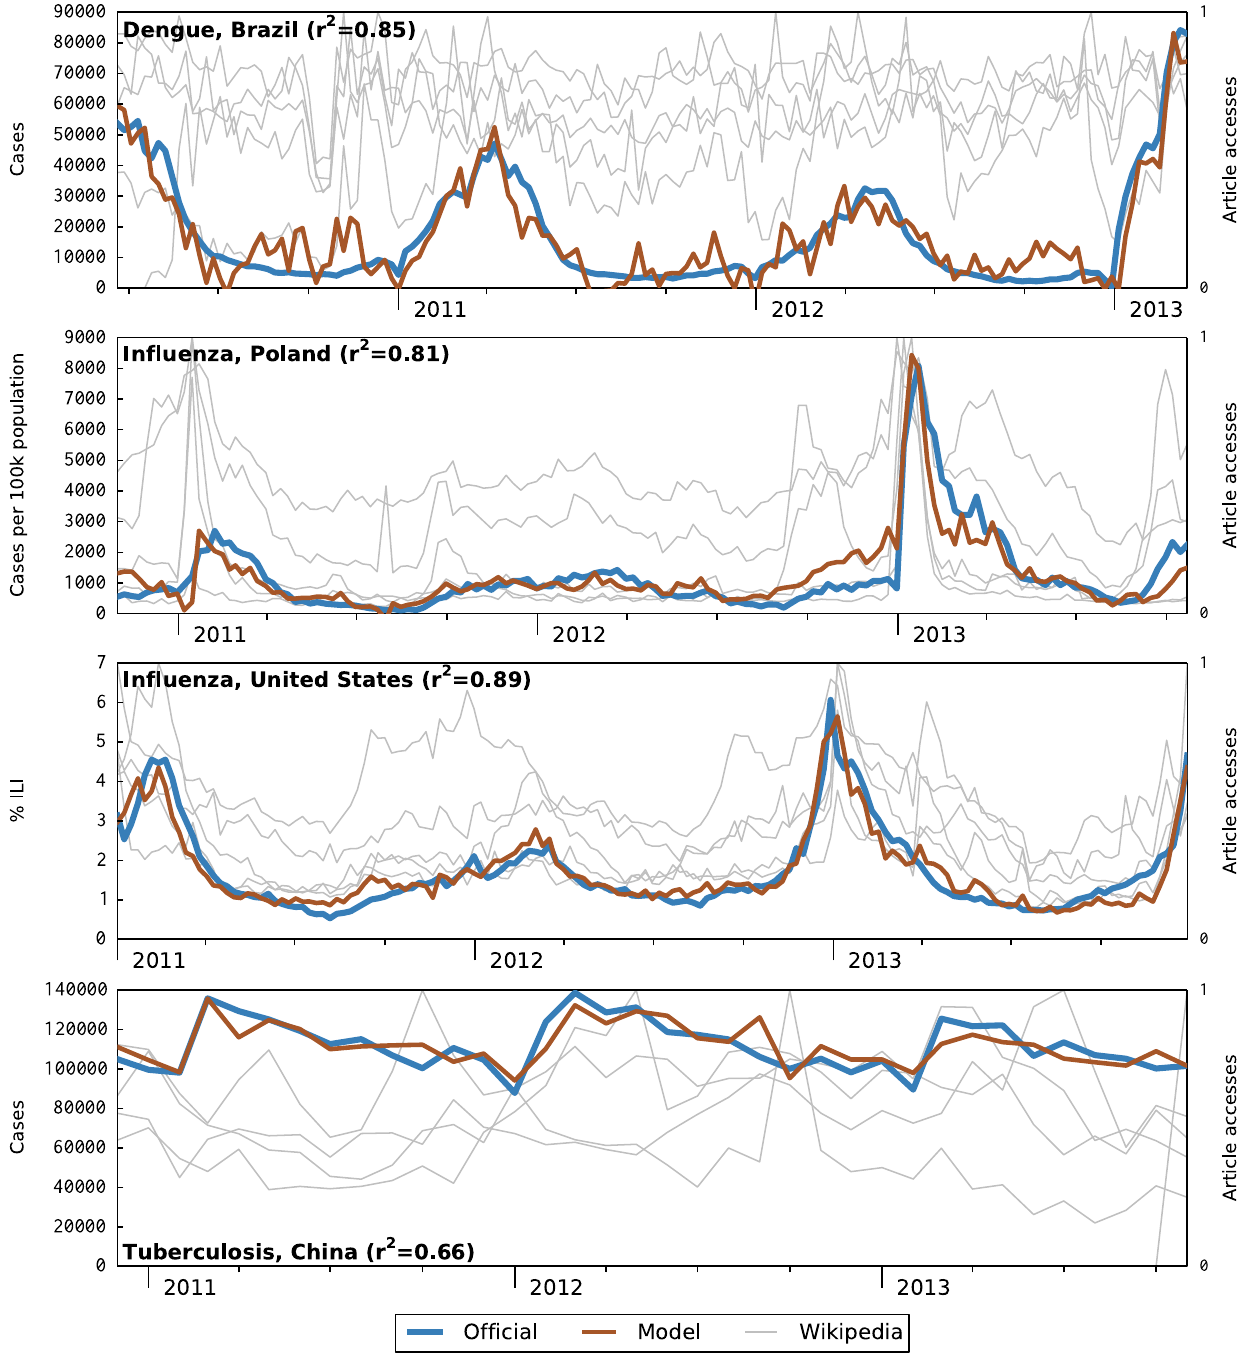
Figure 1. Selected successful model nowcasts. These graphs show official epidemiological data and nowcast model estimate (left Y axis) with traffic to the five most-correlated Wikipedia articles (right Y axis) over the 3 year study periods. The Wikipedia time series are individually self- normalized. Graphs for the four remaining successful contexts (dengue in Thailand, influenza in Japan, influenza in Thailand, and tuberculosis in Thailand) are included in the supplemental data file